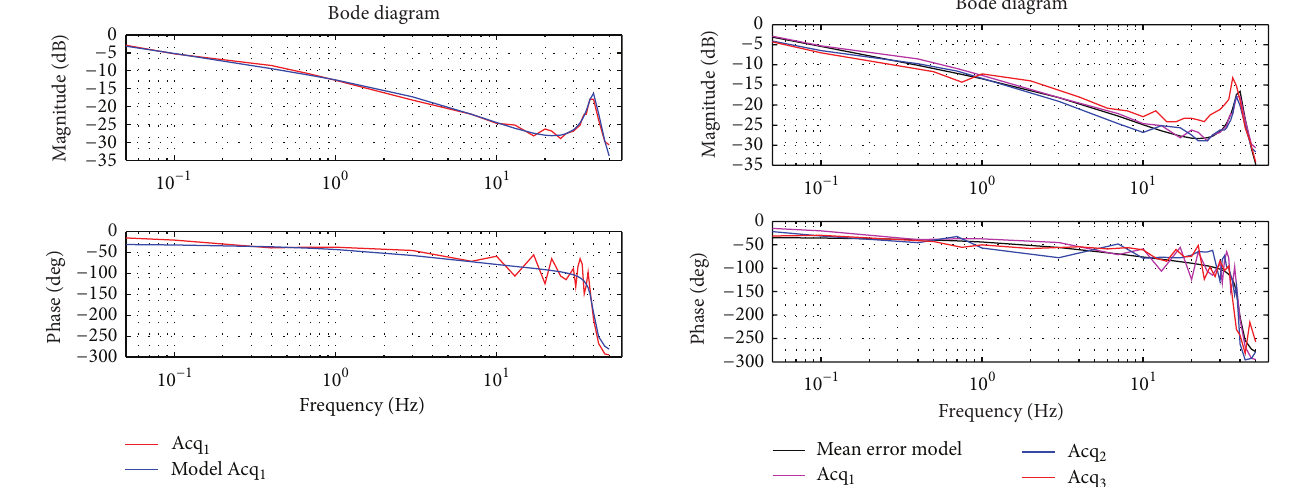
Figure 11: Magnitude and phase of the mean model on Acq 1 , Acq 2 , and Acq 3 via simplex